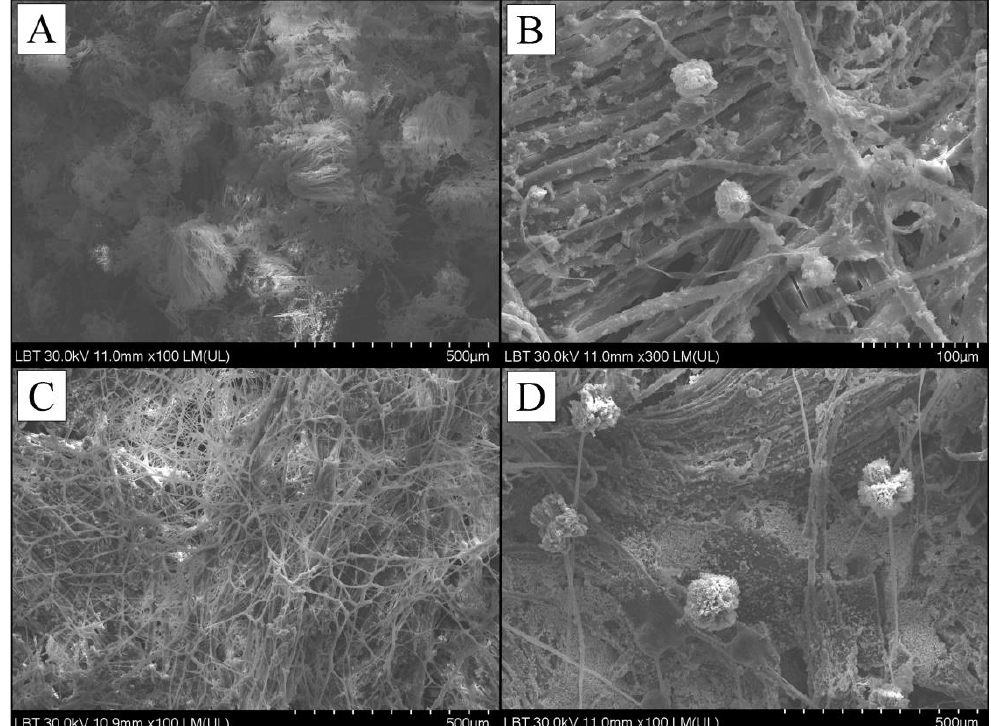
Figure 7. SEM analysis of sample number 1 of canvas from the walls of the wooden church. ( A ) — SEM image of the surface inoculated with fungi of Aspergillus tamarii species; ( B ) — SEM image of the surface inoculated with fungi of Aspergillus tamarii species after applying UVB treatment; ( C ) — SEM image of the surface inoculated with fungi of the species Cladosporium cladosporiodes ; ( D ) — SEM image of the surface inoculated with fungi of the species Cladosporium cladosporiodes after application of UVB treatment.